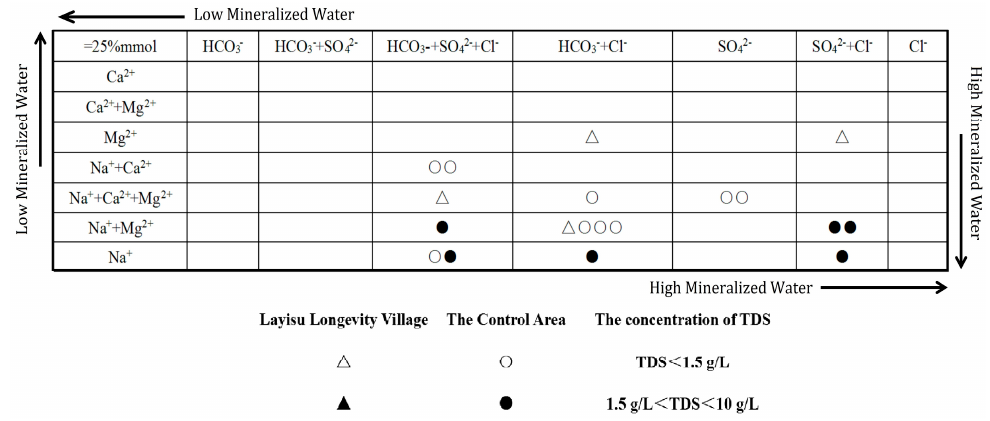
Figure 2. Shukalev classification diagram [21] of groundwater samples in LLV and CA.